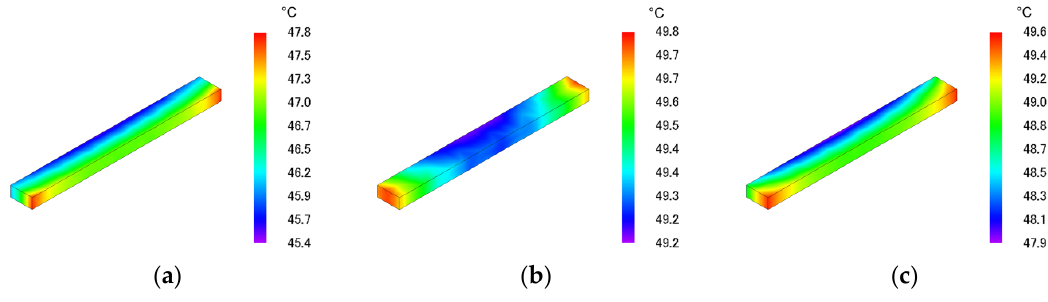
Figure 18. Temperature distributions in the magnet when NdFeB is employed. ( a ) PM ‐ top; ( b ) PM ‐ bottom; ( c ) PM ‐ middle ‐ 1& ‐ 2. Table 4. Typical temperature values in PMs when NdFeB is employed.